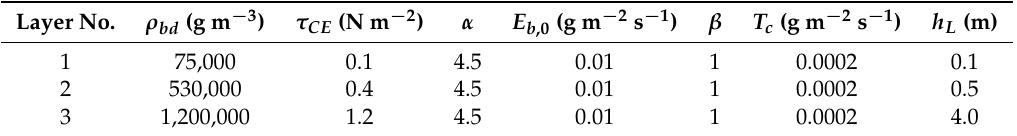
Table 1. Parameters of the multilayer bed model. Here, ρ bd is the dry density, T c is the consolidation rate, h L is the layer height, and the other parameters are defined in Equation (21). Layer No. ρ bd (g m − 3